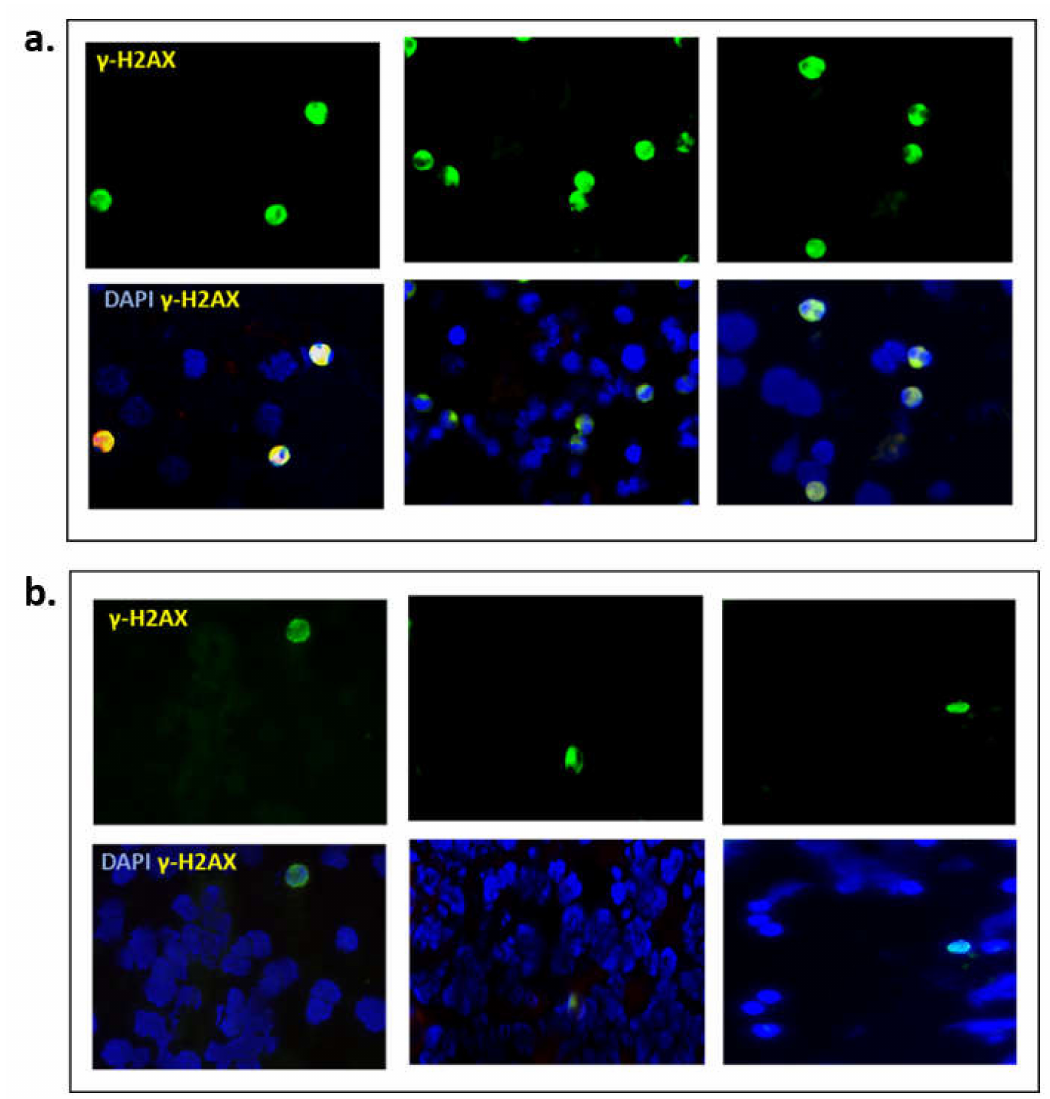
Figure 6. Representative images from ( a ) three BRCAm ovarian cancer patients ( b ) three BRCA wt patients, all undergoing chemotherapy. γ -H2AX positive cells were captured using immunofluorescence, magnification ×